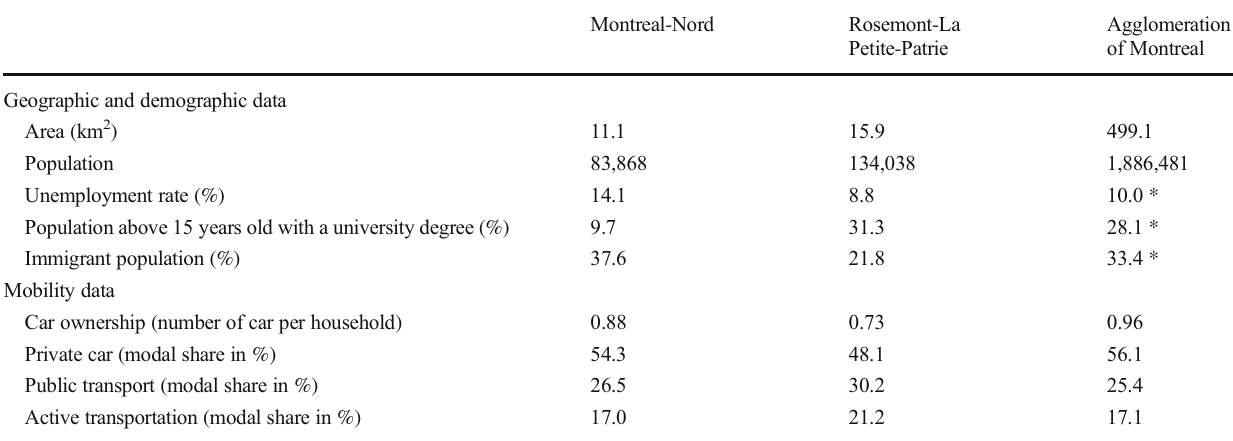
Demographic and mobility statistics for the two boroughs and the agglomeration of Montreal